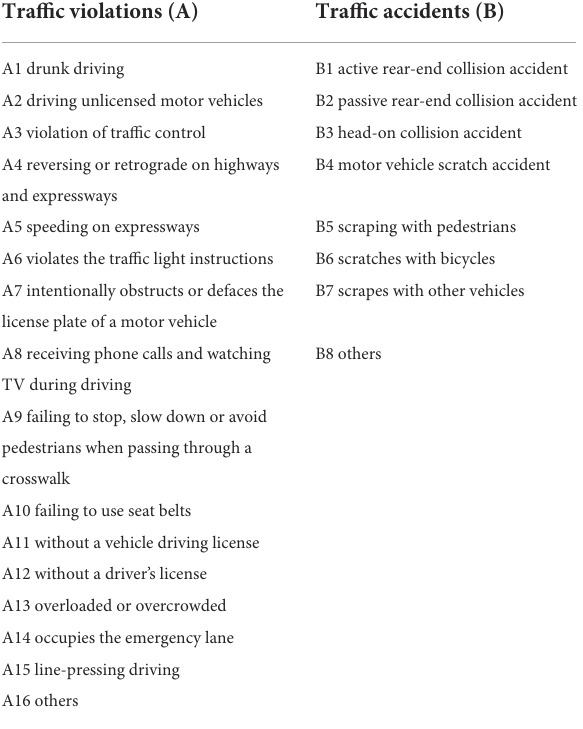
TABLE 1 List for main traffic violations and traffic accident